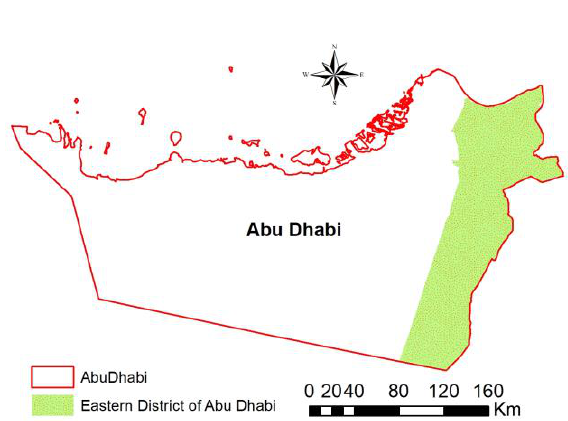
Figure 4. LULC map of the study Figure 3. OOC was applied to WV-2 images at eastern district of Abu Dhabi to separate three different age stages of date palm plantations WV-2 characterized by its multispectral bands (eight bands and one panchromatic) with 1.85m spatial resolution for the eight bands and submeter (0.46m) for the panchromatic. For each image selected, only three bands plus the panchromatic band of WV-2 were used and saved in ERDAS Imagine (.img) format. The three bands: band 3 (green), band 5 (red), and band 7 (NIR1)